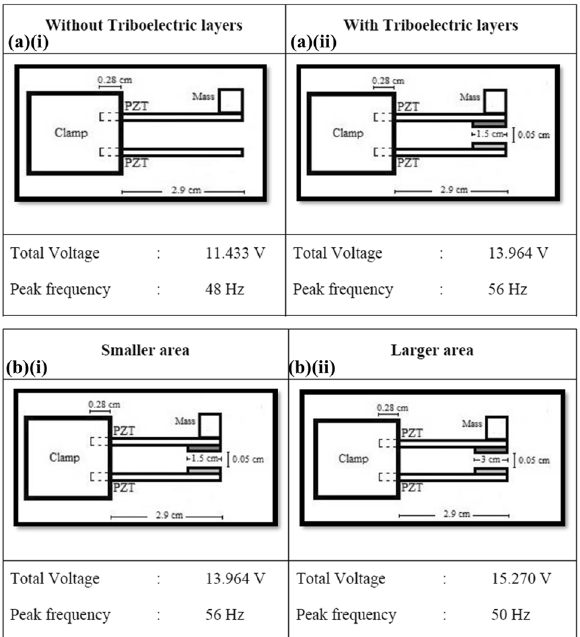
Figure 7. Performance enhancement of MT-HPTEH: ( a ) with and without triboelectric surface, ( b ) with different triboelectric